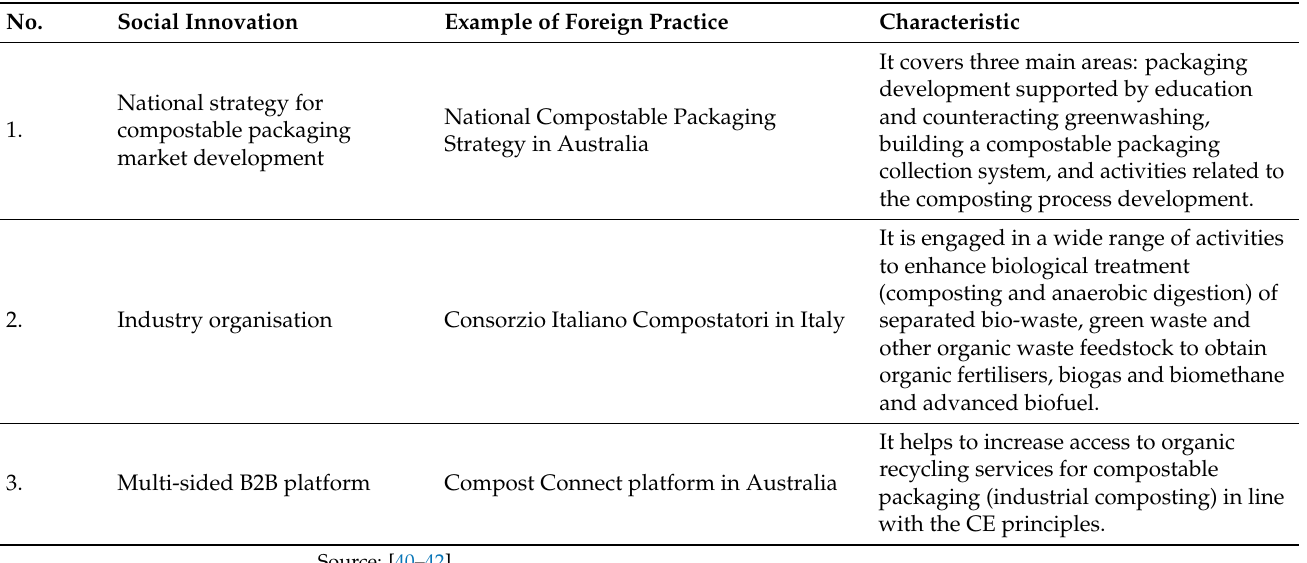
Table 3. Examples of social innovations from foreign